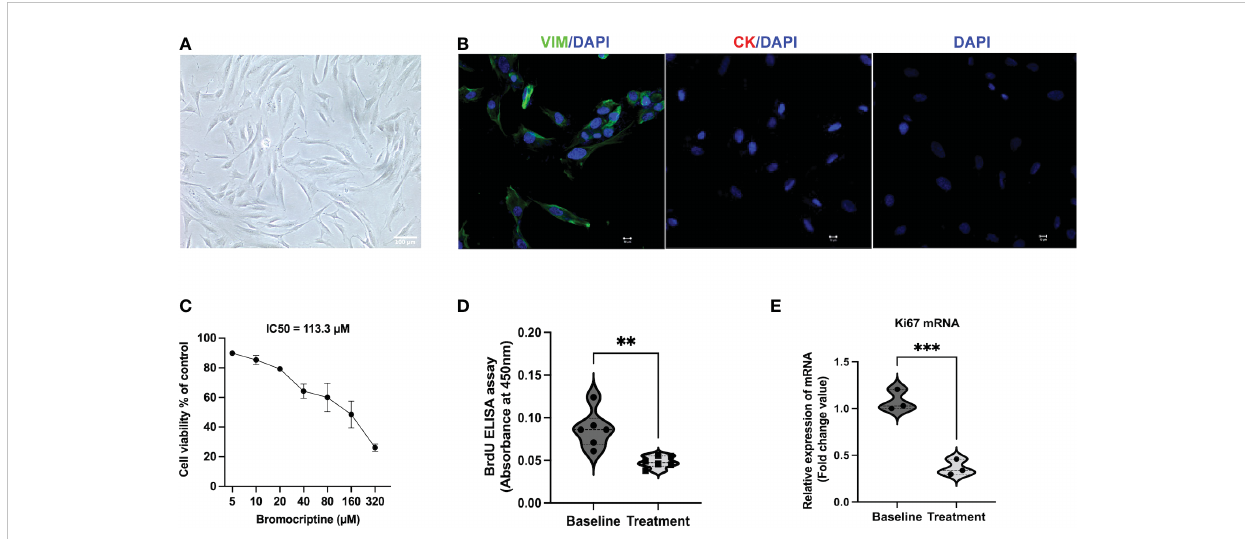
FIGURE 2 Identi fi cation of endometrial stromal cells derived from women with adenomyosis and the effect of bromocriptine on cell proliferative ability in vitro . (A) The primary endometrial stromal cells in adenomyosis showed a typical spindle-shaped morphology under a light microscope (Magni fi cation of 20×, scale bar:100 m m). (B) Cultured cells were positive for vimentin (Green) and negative for cytokeratin (Red) by immuno fl uorescent staining. (C) Effect of various doses of bromocriptine (5, 10, 20, 40, 80, 160, 320 m M) on endometrial stromal cells (n=3). After 48 hours treatment of